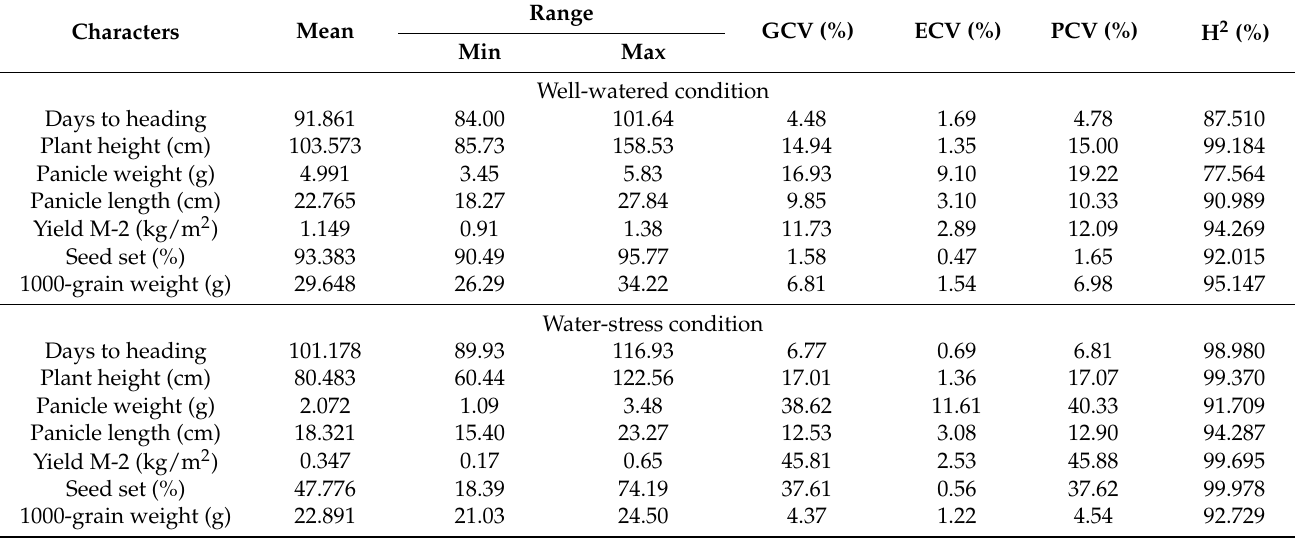
Table 3. Estimate of genetic parameters, heritability in the broad sense, for yield and its component characters under well irrigated and 15 d water stress